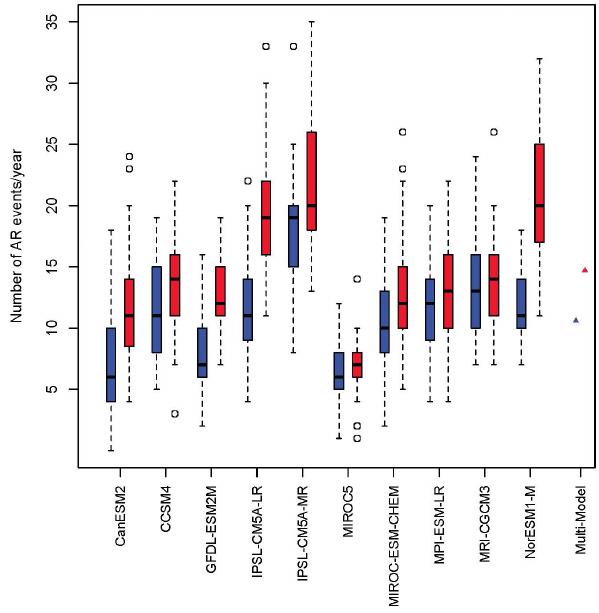
Figure 2. Boxplot summaries of annual values of atmospheric river days (AR days, unit: daysyr − 1 ) for the California region from each CMIP5 model during the 25 years, spanning 1981–2005 (blue box- plot) and 2076–2100 under RCP8.5 (red boxplot). Blue and red tri- angles represent the ensemble mean of AR days for the historical and RCP8.5 runs, respectively.